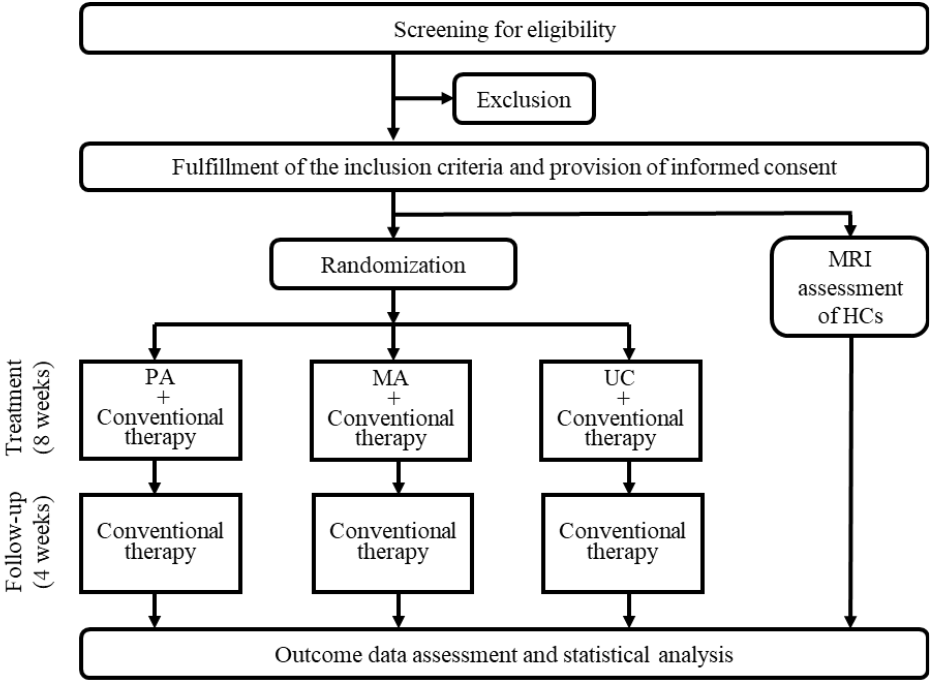
Figure 1. Subject selection flowchart. PA, pharmacopuncture; MA, manual acupuncture; UC, usual care; MRI, magnetic resonance imaging; HC, healthy control.